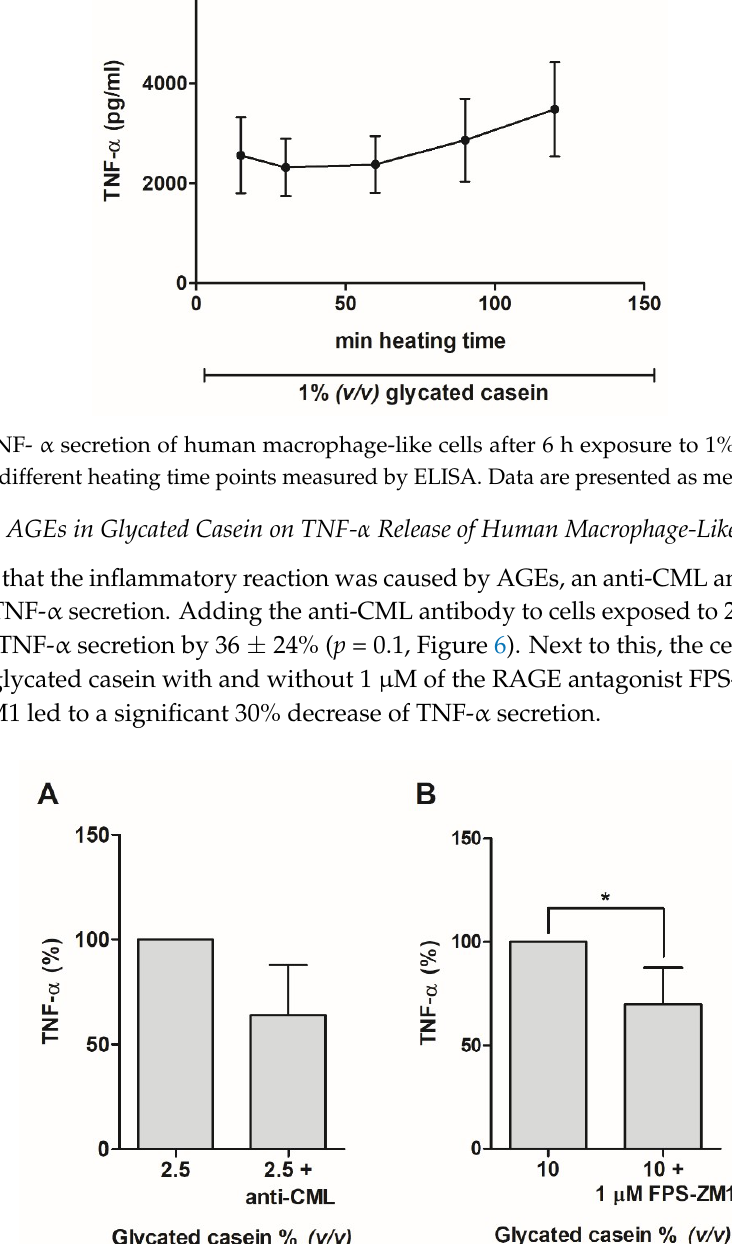
Figure 6. ( A ) TNF-α secretion of human macrophage-like cells after 6-hour exposure to 2.5% ( v/v ) glycated casein with or without anti-CML antibody measured by ELISA. After addition of an anti- CML antibody, TNF-α secretion decreased by 36% ± 24%. Data are presented as mean ± SD, n = 3. ( B